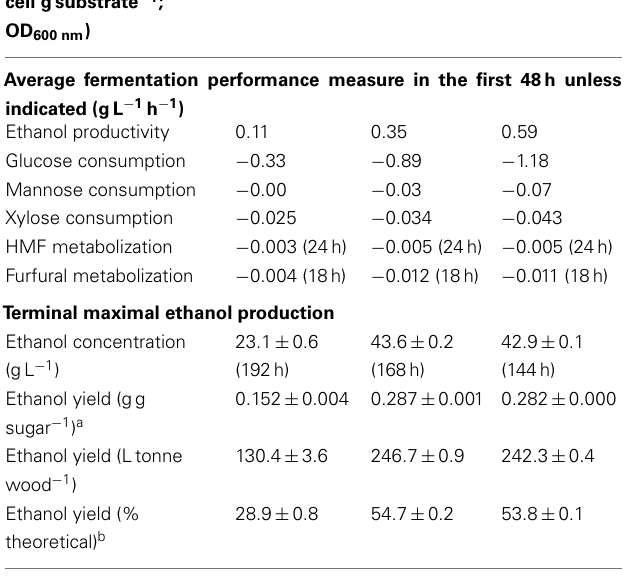
FIGURE 3 |Time-dependent ethanol production and sugar consumptions during Q-SSF of the whole slurry of SPORL pretreated NE222 at 20% total solids loading without detoxification . (A) Ethanol and glucose; (B) Xylose; (C)